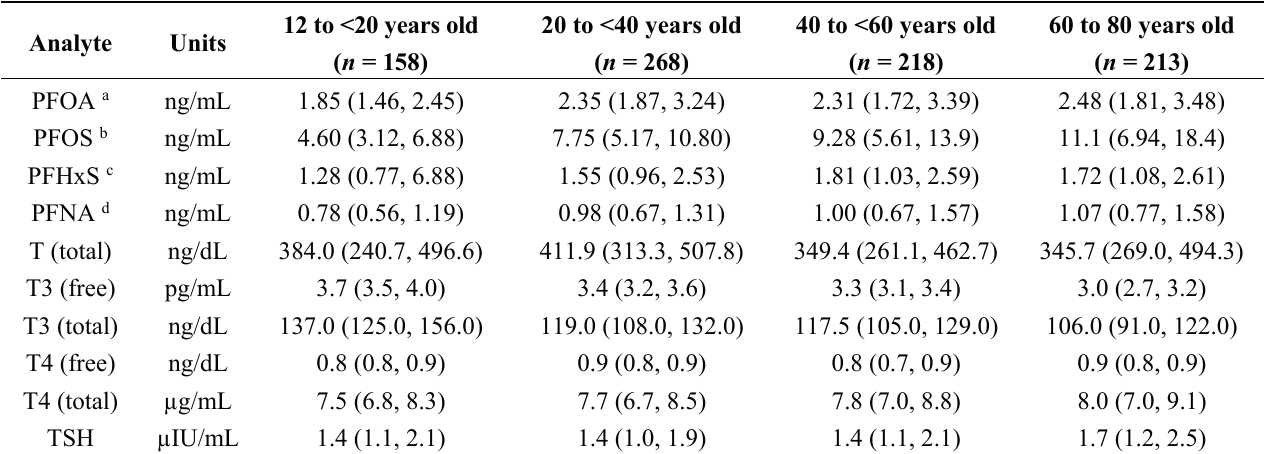
Table 2. Median (25th percentile, 75th percentile) serum concentrations of PFASs and hormones among males from NHANES